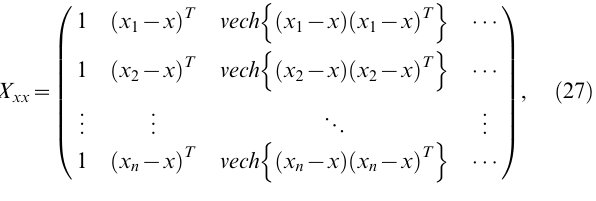
Figure 3 indicates the variance of the error term function and